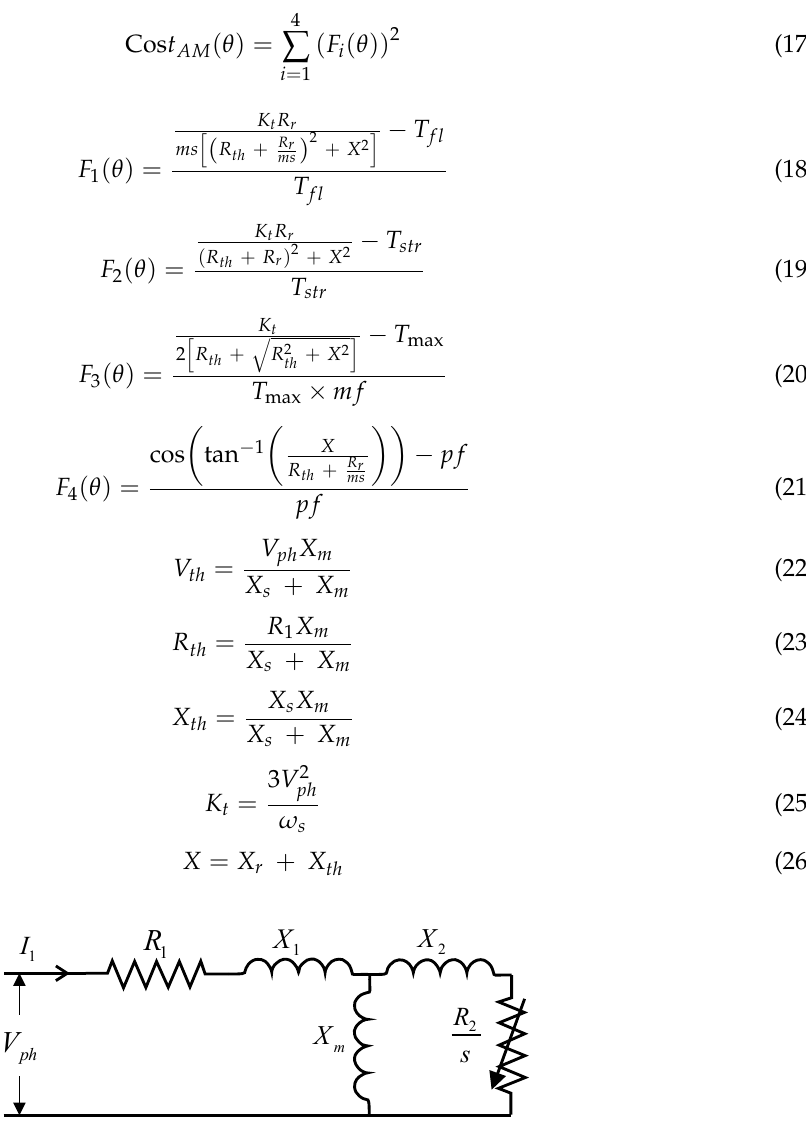
Figure 3. Exact Circuit Model.